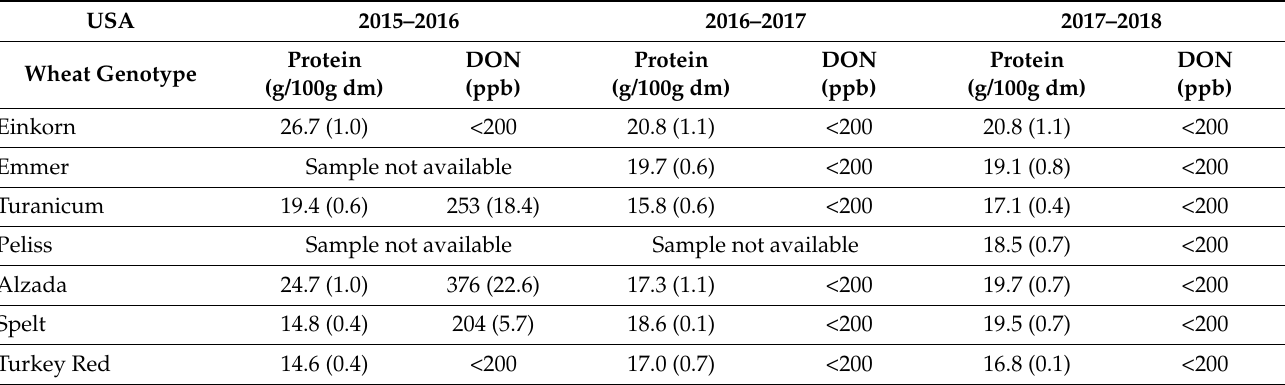
Figure 1. Total precipitation and mean temperatures over the cultivation years for 2015–2016 ( a ), ( f ) in Italy. Table 1. Protein and DON mean content of the wheat samples grown in the USA and in Italy. Standard deviation (SD) is reported in brackets in the